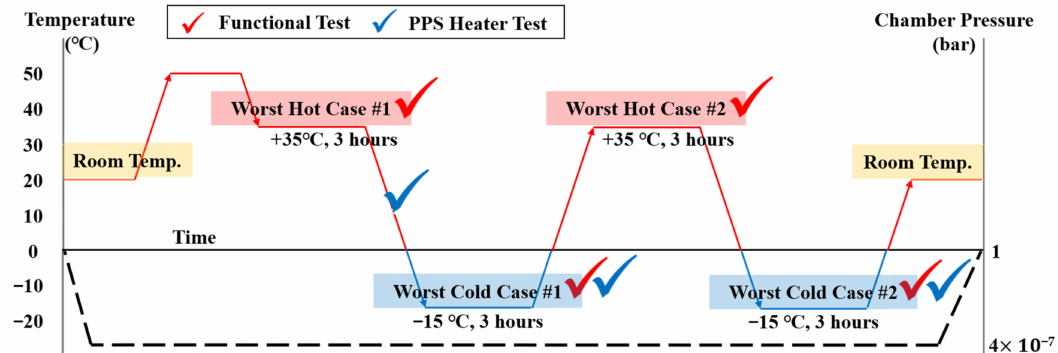
Figure 16. Temperature profile and procedure of TVCT.